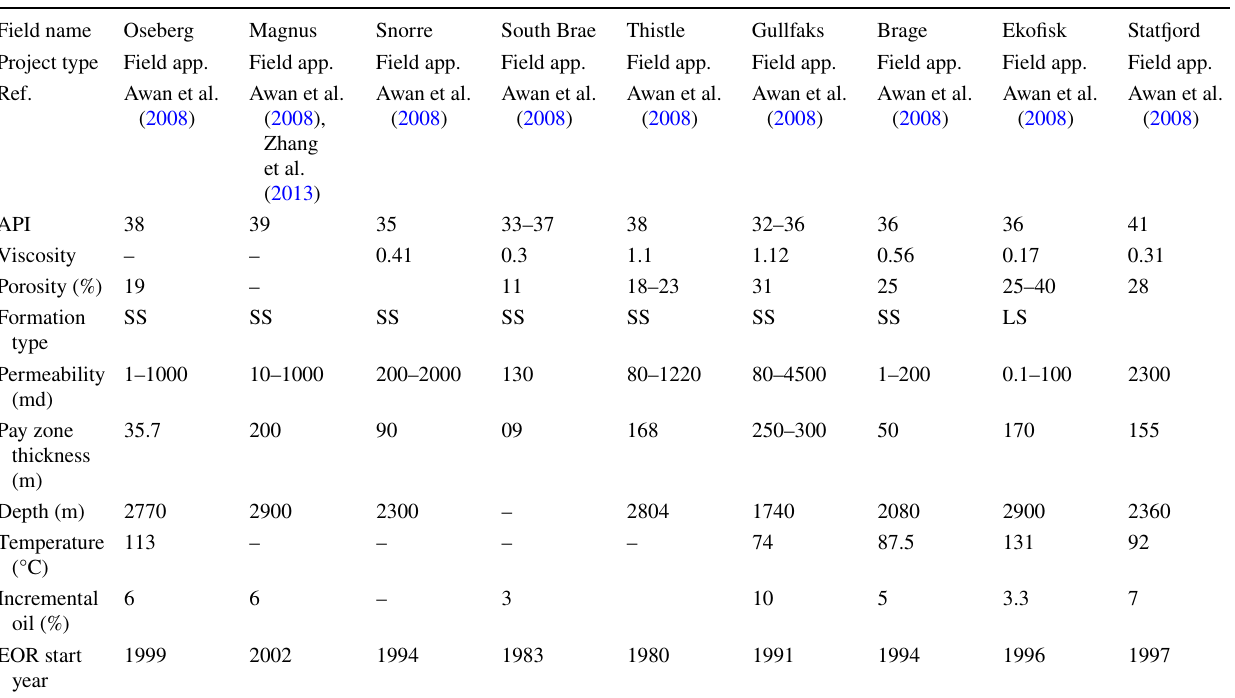
Table 3 Reservoir data for WAG field projects in the North